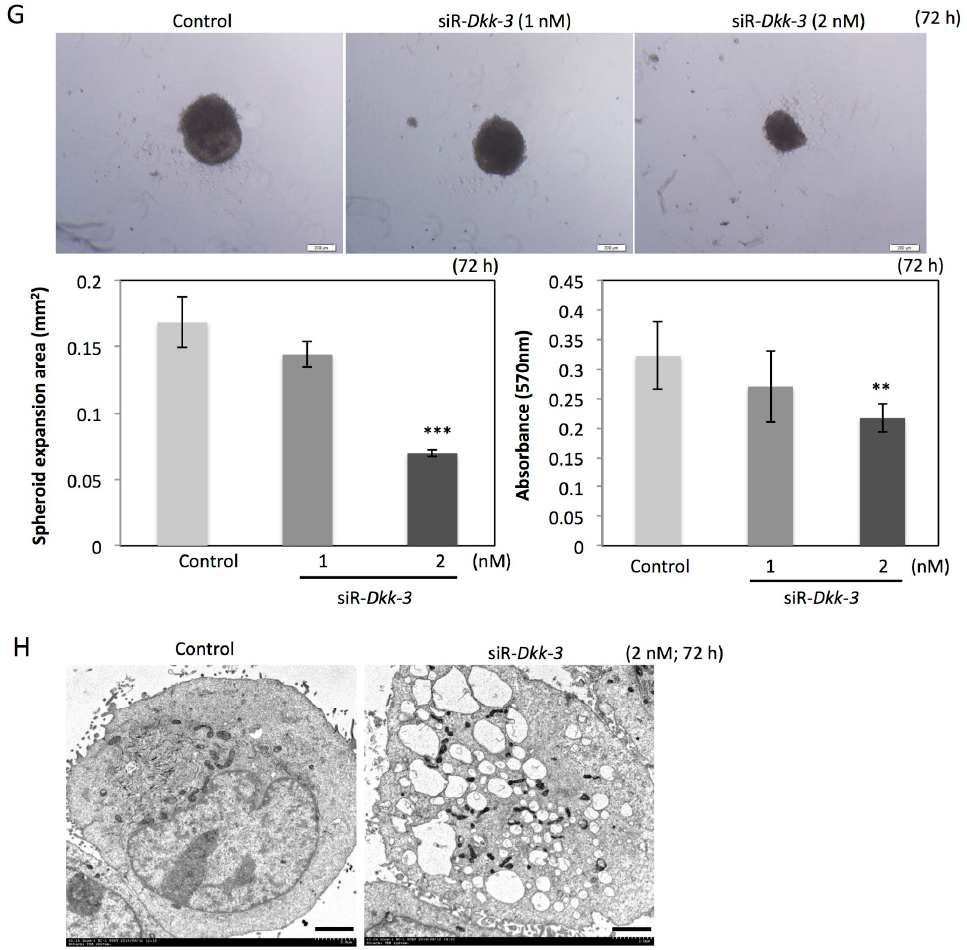
Figure 2. Anti-oncogenic effects of Dkk-3 knock-down by using siR- Dkk-3 or miR-92a in T24 cells. ( A , B ) Cell viability ( A ) and protein expression profiles ( B ) in T24 cells at 72 h after transfection with non-specific siRNA or siR- Dkk-3 (1, 2 or 5 nM); ( C , D ) Cell viability ( C ) and protein expression profiles ( D ) in T24 cells at 72 h after transfection with non-specific siRNA or miR-92a (10 or 20 nM). Dkk-3 expression also examined in T24 cells transfected with non-specific siRNA (20 nM), non-specific siRNA (10 nM) + miR-92a (10 nM) or miR-92a (10 nM) + antagomiR-92a (10 nM); ( E , F ) Cell-cycle distribution of T24 cells at 72 h after transfection with non-specific siRNA, siR- Dkk-3 or miR-92a. Cells were classified into 4 phases; sub-G1 phase (red), G0/G1 phase (yellow), S phase (blue), and G2/M phase (green); ( G ) 3D spheroid colorimetric proliferation/viability assay in T24 cells at 72 h after the spheroid formation. The spheroid expansion area was calculated according to the manufacturer’s protocol. Absorbance at 570 nm means viability of the spheroid assessed by the MTT assay. Scale bars, 200 µ m; ( H ) Electron microscopic observation of T24 cells at 72 h after transfection with non-specific siRNA or siR- Dkk-3. Scale bars, 2 µ m. The p -values in ( A , C , F , G ) are indicated as follows: * p < 0.05, ** p < 0.01 and *** p <